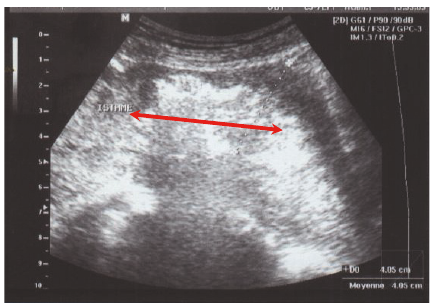
Figure 2: Ultrasonography aspect of the placenta increta